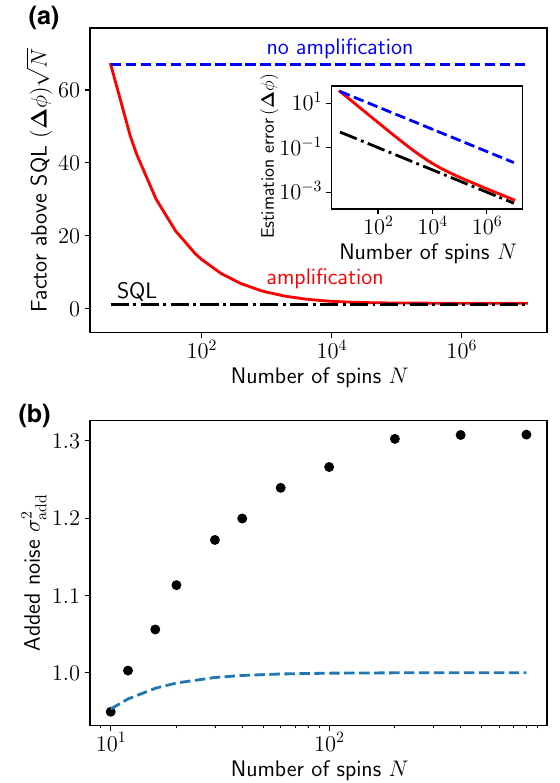
FIG. 3. (a) The suppression of detection noise by amplifica- tion. The best reported fluorescence readout of a NV ensemble (cid:16) ˜ is a factor of (cid:13) det = 1 / C 2 n avg = 67 above the SQL [16]. We assume the ideal case where this factor is independent of the ensemble size (dashed blue line). Amplification suppresses the readout noise (solid red line) and allows us to approach the SQL (dash-dotted black line). The inset shows the scaling of the total estimation error ( (cid:2) φ) 2 with and without amplification (solid red and dashed blue lines, respectively) and the SQL (dash-dotted black line). The curves are obtained using a MFT analysis of Eq. (3) for γ rel /(cid:5) = 0 and agree qualitatively with numerically exact solutions of the master equation (3) which are used to calculate [defined in Eq. (15)] for γ rel /(cid:5) = 0. The the (b) added noise σ 2 add dash-dotted blue line illustrates the expected minimum amount of added noise, 1 − 1 / G 2 N , based on a heuristic argument max detailed in the Supplemental Material [53]. Note that this is not a strict lower